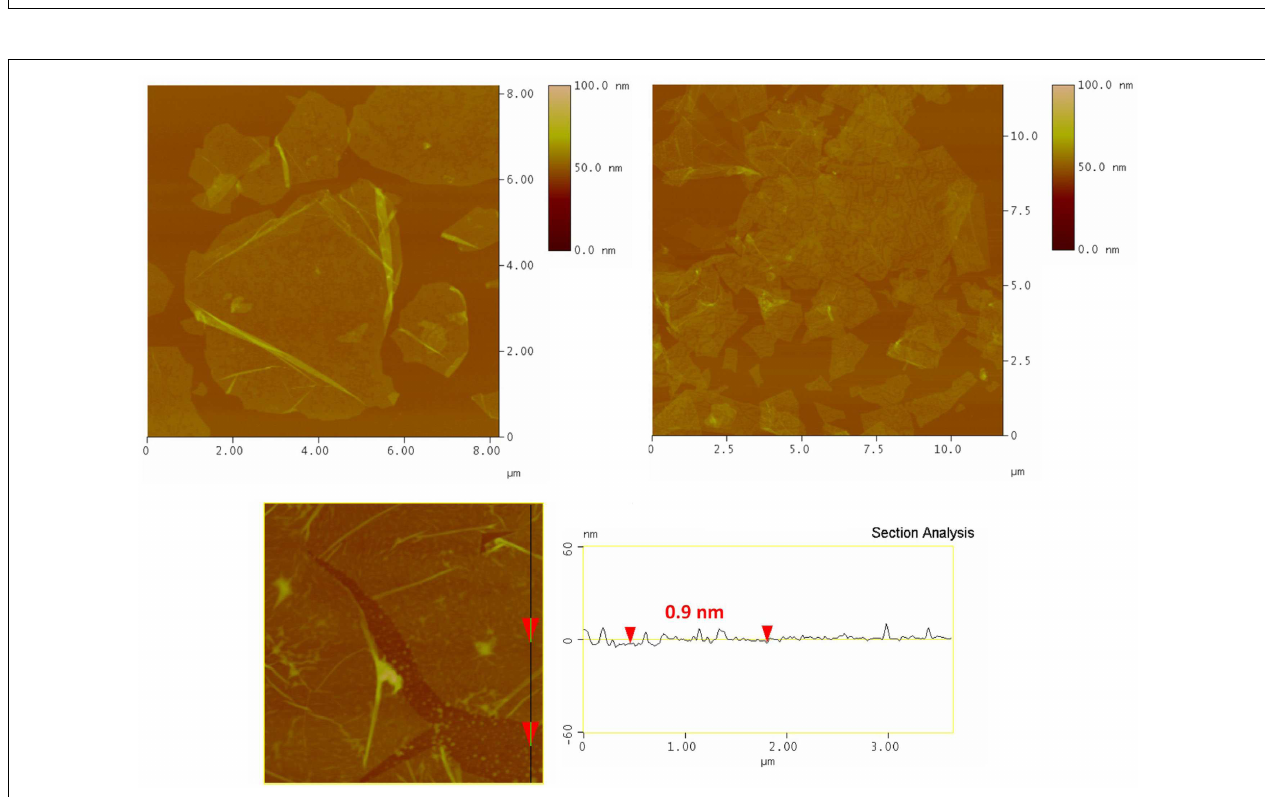
FIGURE 2 |Tapping modeAFM micrographs (and line profile) of a ODA–GO monolayer deposited with the Langmuir–Schaefer technique at a surface pressure of 20mNm − 1 .